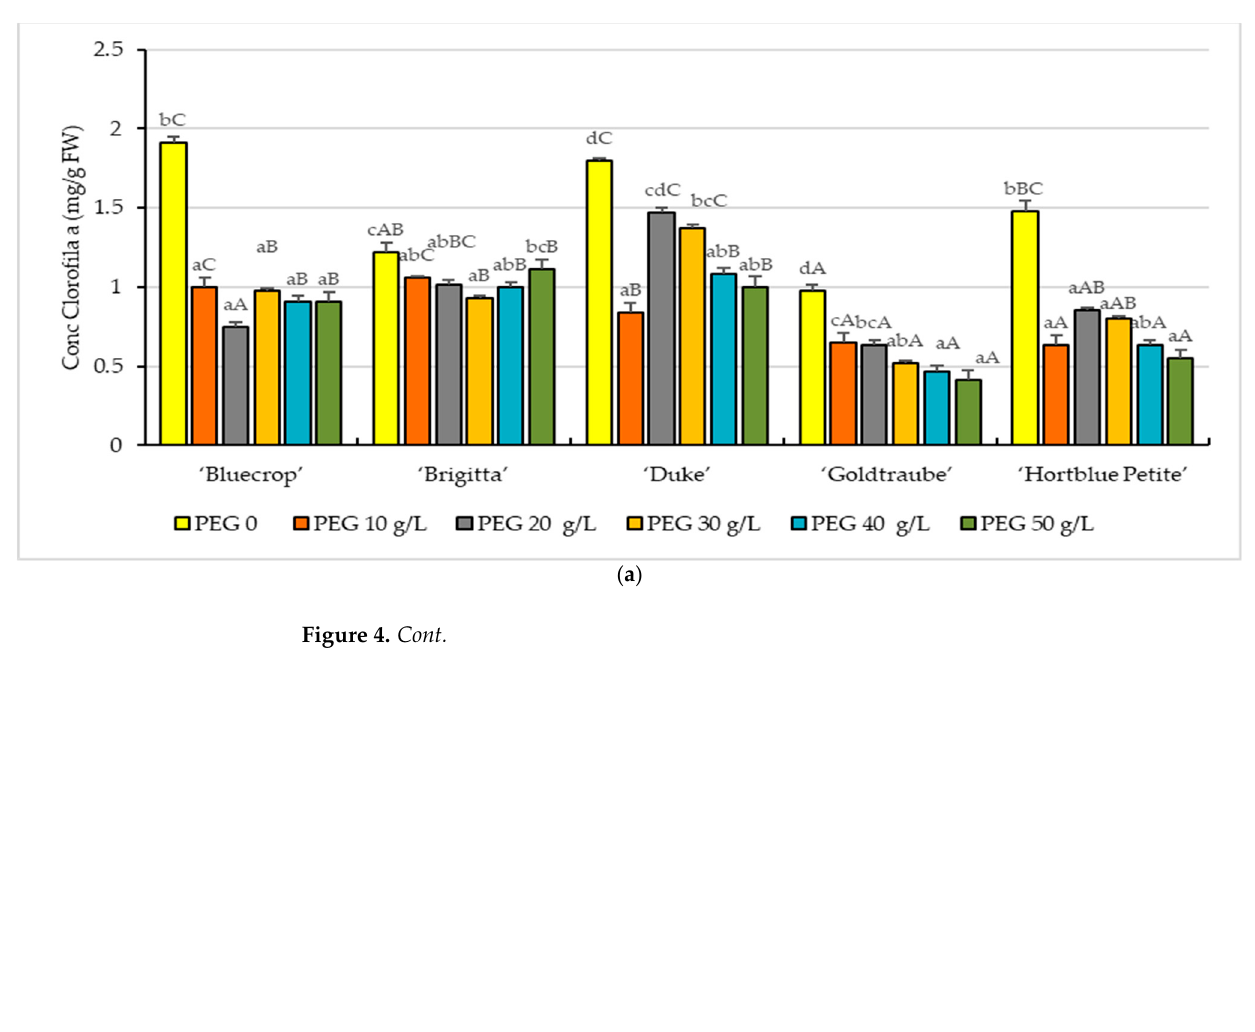
8 of 16 Figure 3. Effects of drought stress on ( a ) fresh weight (FW), ( b ) water content (WC) of five in vitro- grown highbush blueberry cultivars (Bluecrop, Brigitta Blue, Duke, Goldtraube and Hortblue Pe-